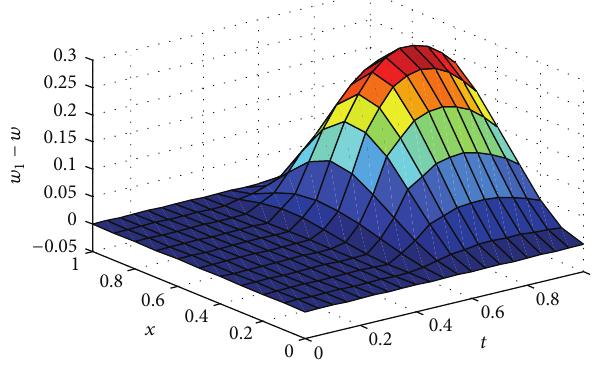
Figure 3: The difference between 𝑤 1 and 𝑤